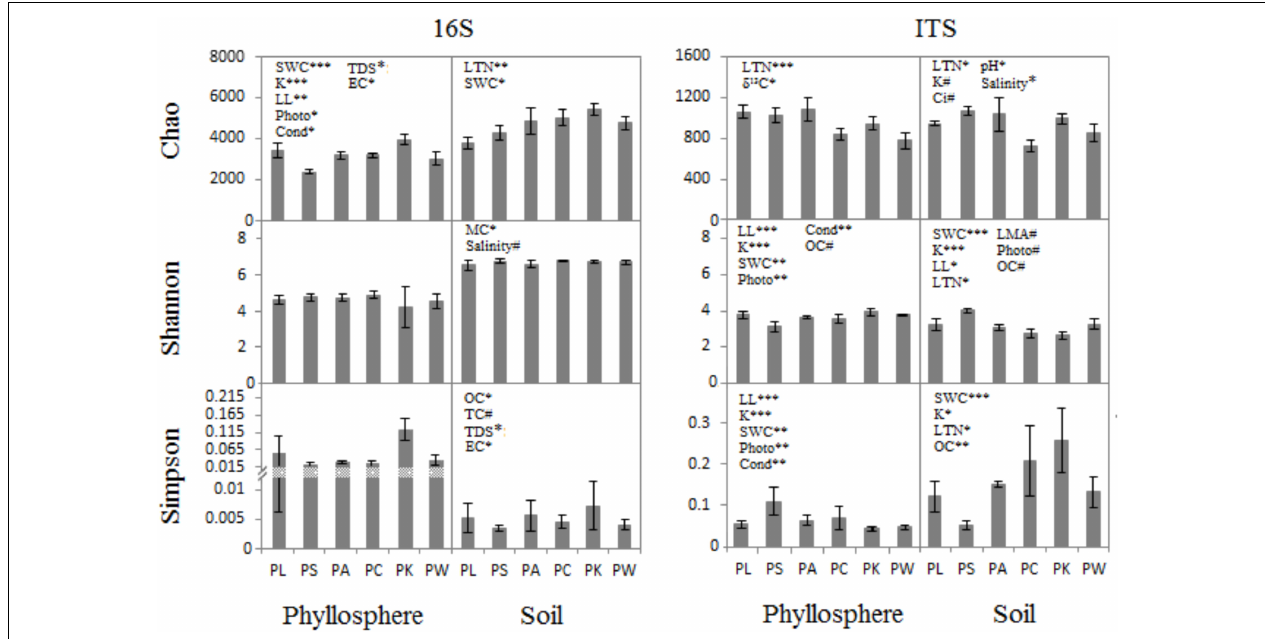
FIGURE 2 | ANCOVA analysis for diversity indices (Mean ± SE) with host and near-root soil characteristics. ∗ p < 0.05; ∗∗ p < 0.01; ∗∗∗ p < 0.001; # p <